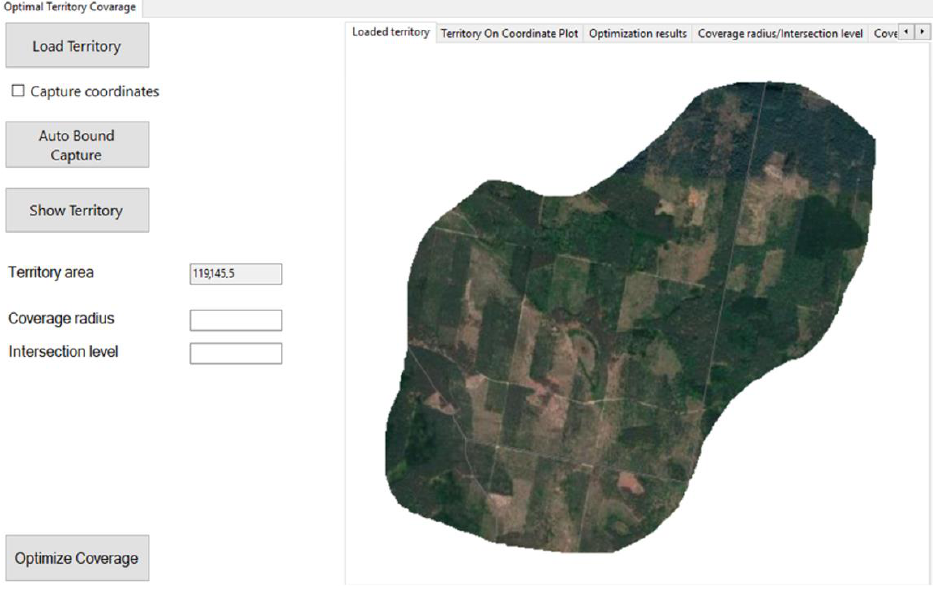
Figure 6. User interface with the loaded territory.